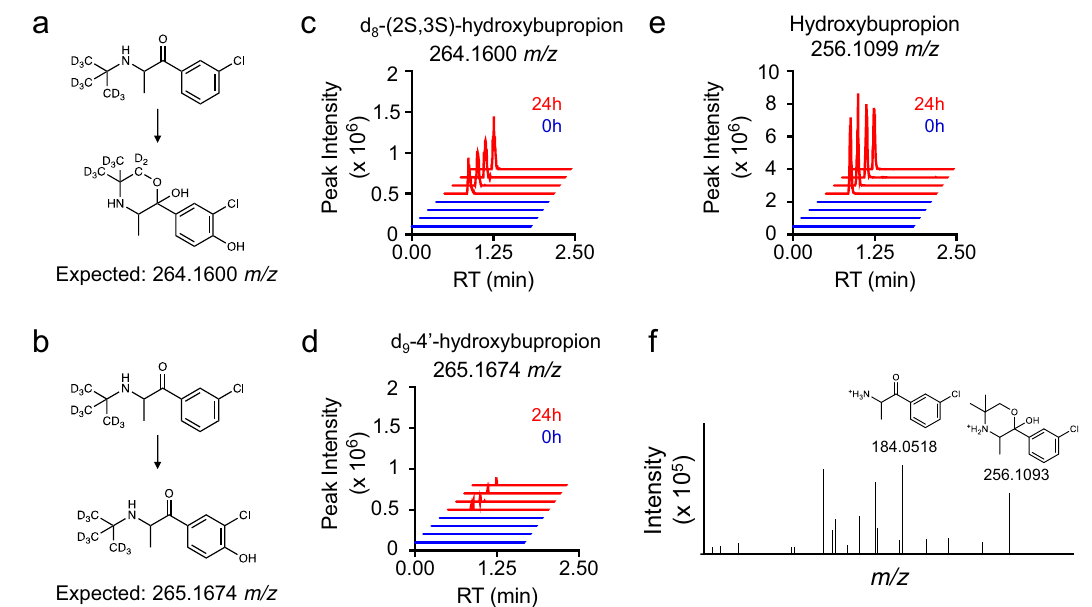
Fig. 3 Stable-isotope assisted metabolite identi fi cation. Use of d 9 -bupropion with S9 enzyme system produces either a d 8 -(2S,3S)-hydroxybupropion or b d 9 -4 ′ -hydroxybupropion. c Extracted ion chromatogram of 264.1600 m / z (d 8 -(2S,3S)-hydroxybupropion) at 0 and 24 h with the addition of d 9 -bupropion. d Extraction ion chromatogram of 265.1674 m / z (d 9 -4 ′ hydroxybupropion) at 0 and 24 h with addition of d 9 bupropion. e Extracted ion chromatogram of 256.1099 m / z (hydroxybupropion) at 0 and 24 h with addition of bupropion. f Mass fragmentation spectrum (MS 2 ) of 256.1099 m / z (black) is consistent with